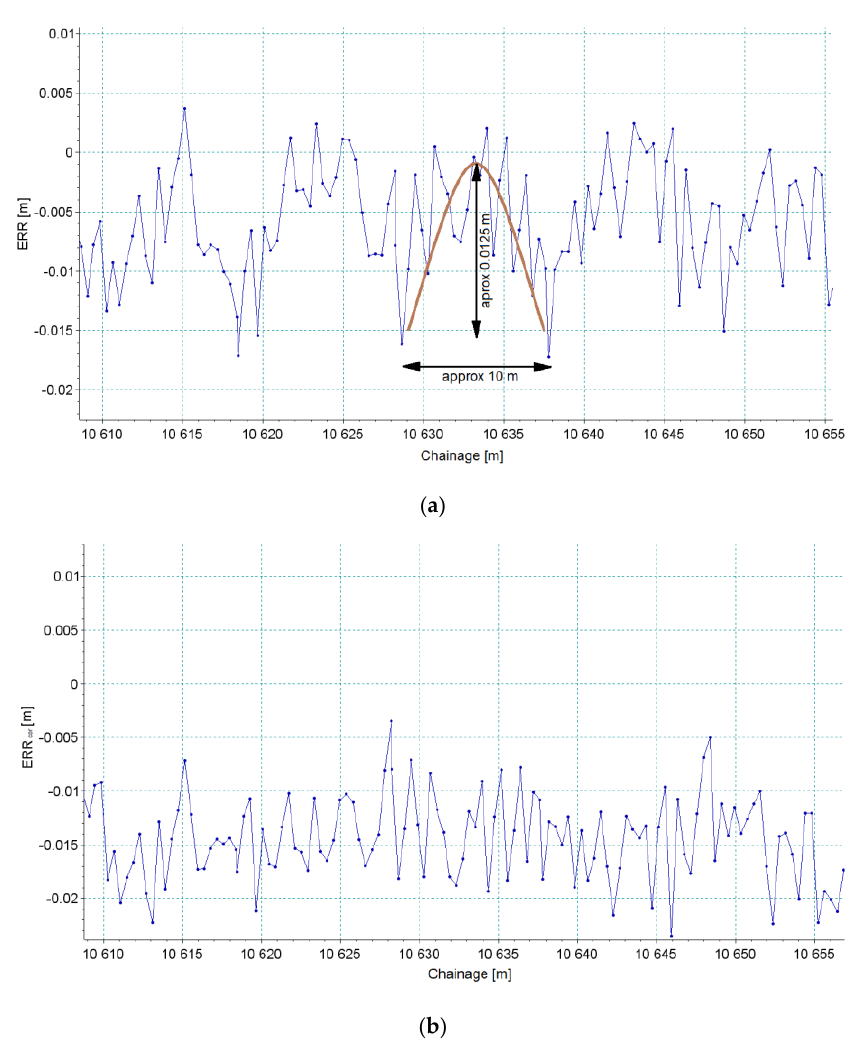
Figure 17. Signal of the ERR value along the length of a fragment of a railway line in a circular curve with a radius of R = 1000 m. ( a ) Signal before correction of the arc versines, ( b ) Signal after correction.